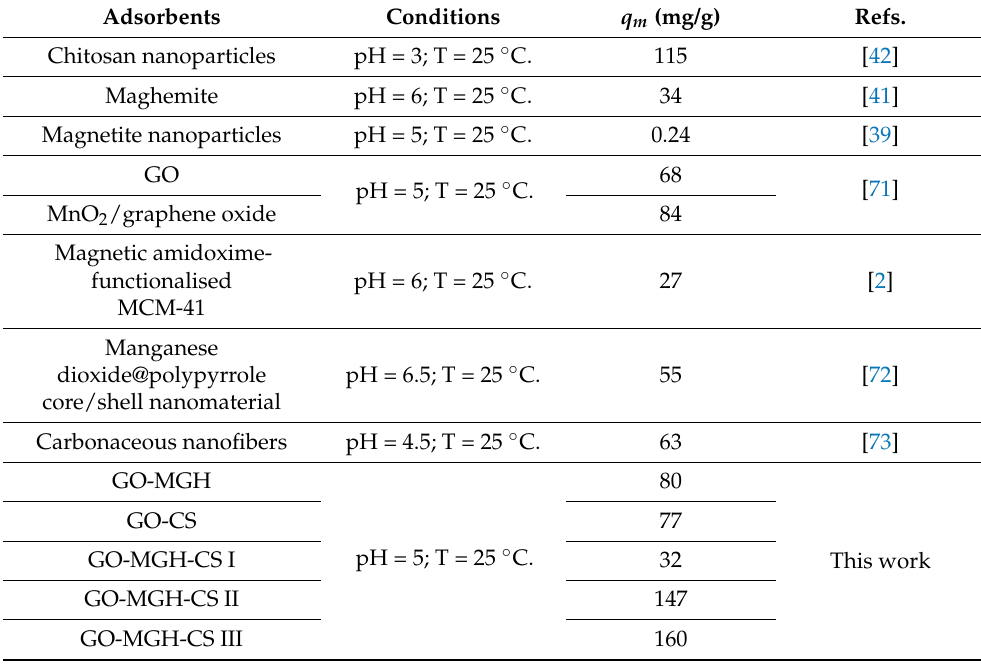
Table 3. Comparison of q m of different adsorbents for Eu(III). Adsorbents Conditions Chitosan